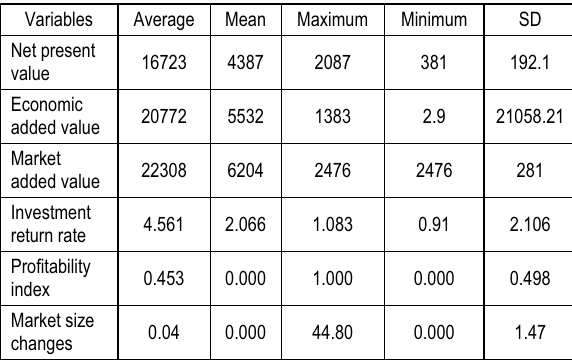
Table 1. Descriptive statistics of the